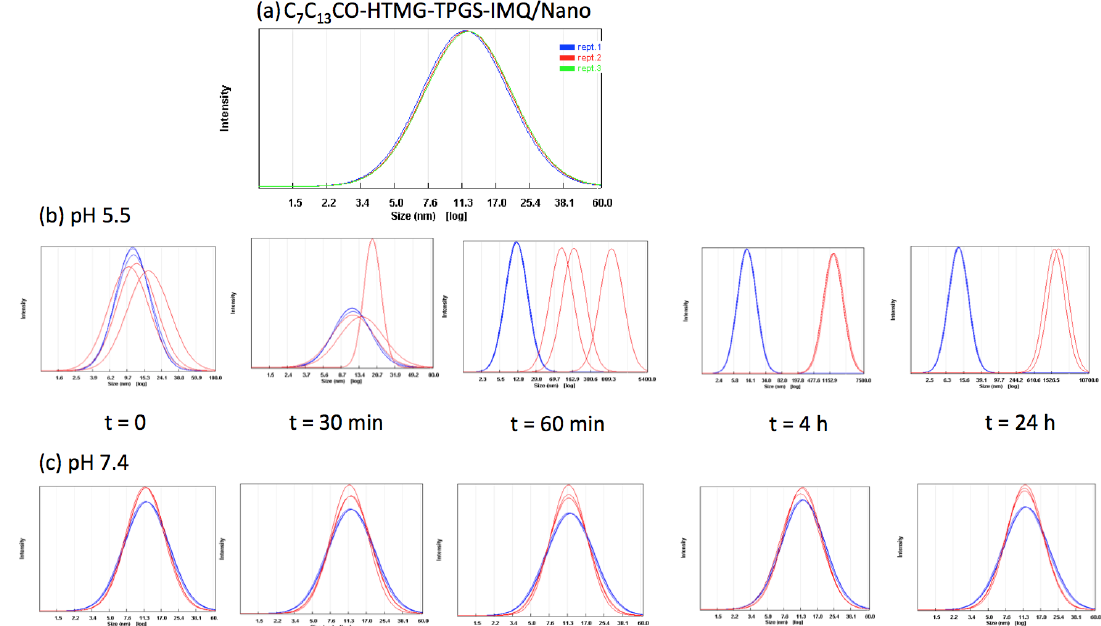
Figure 6. Particle size distribution of C 7 C 13 CO-HTMG-TPGS-IMQ / Nano: ( a ) in deionized water, ( b ) in the simulated endo / lysosome conditions (pH = 5.5, red line) vs. deionized water (blue line), and ( c ) at physiological pH (pH = 7.4, red line) vs. deionized water (blue line) at predetermined time intervals.